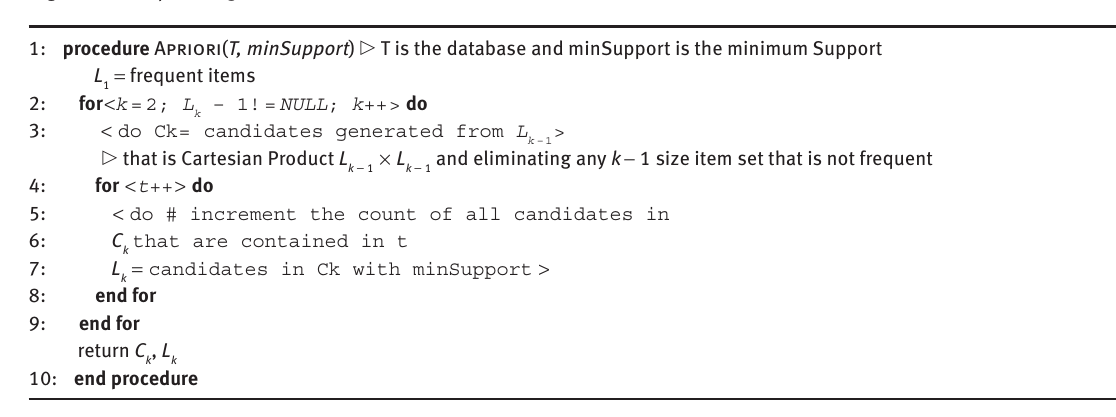
Algorithm 1: Apriori Algorithm Pseudo